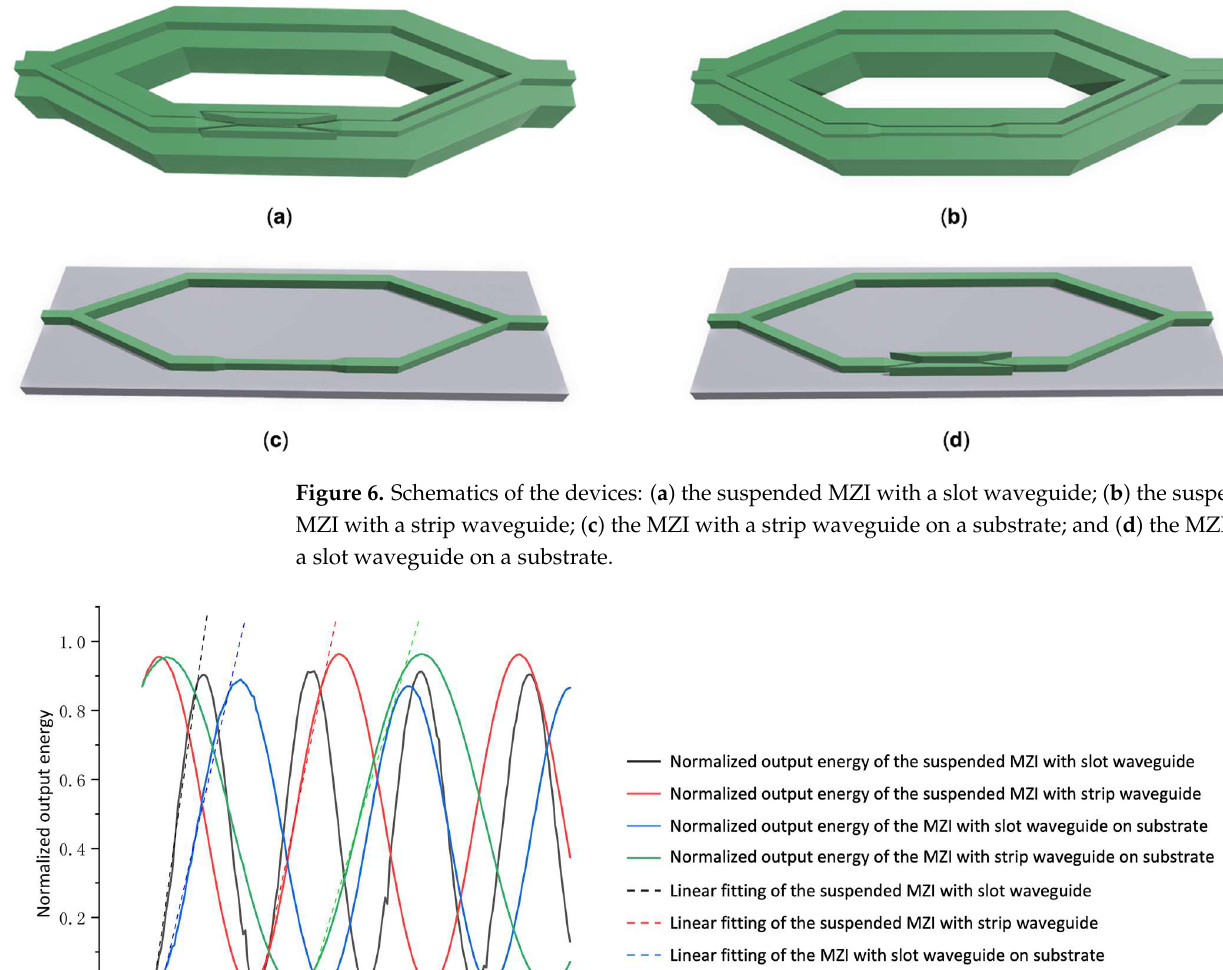
Figure 8. The simulated optical field of the suspended MZI with a slot. Regarding polymer slot waveguides, the variation in sensing accuracy with wave- length change is significantly higher than that of ridge waveguides and silicon slots. One of the main reasons is that its mode changes with wavelength, and the other is that the polymer has a high sensitivity to wavelength change owing to its low refractive index. Therefore, we analyzed the relationship between the normalized output energy with the refractive index for the structure at different wavelengths near the communication wave- length of 1550 nm. As shown in Figure 9, when the reflective index varies from 1.33 to 1.34, the corresponding 𝑆 (cid:3031) for wavelengths of 1500, 1550, and 1600 nm are 1049.4, 972.1, and 935.9 dB/RIU, respectively. It can be concluded that the shorter wavelength will lead to better mode confinement, resulting in a higher normalized output energy. Therefore, the sensing accuracy can be enhanced by reducing the wavelength. In addition, the rapid